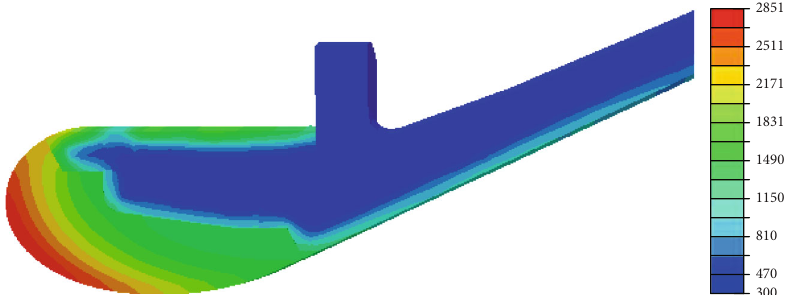
Figure 7: Temperature distribution under the thermal loading at time 28 s, K.